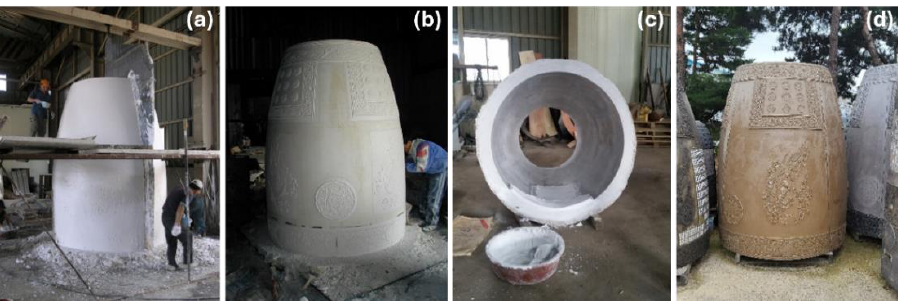
Figure 13. The fabrication process of a bell form. ( a ) A POP bell form, ( b ) an engraved plaster bell form, ( c ) an intaglio FRP bell form, and ( d ) a completed bell form.